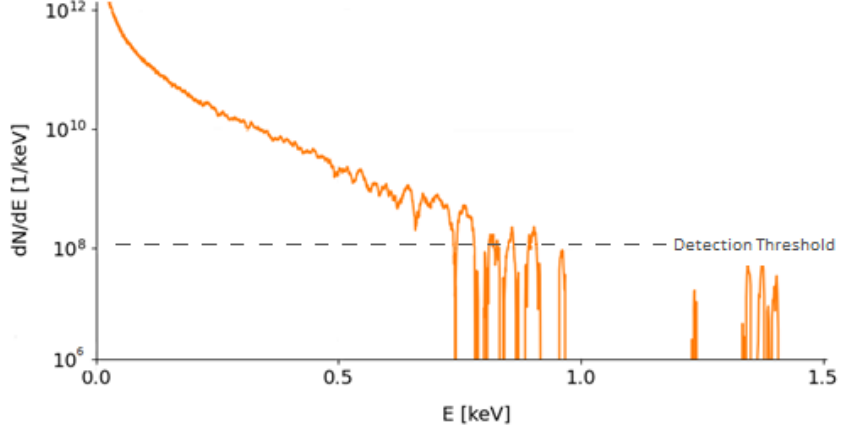
Figure 1. Typical energy distribution obtained from residual ion acceleration. Data gathered from an experimental campaign that was performed at HiLASE centre, intensity 2.2 × 10 16 W/cm 2 laser shots incident on a 2 mm Cu target. Detection threshold marks (in KeV) the value at which the signal noise becomes equal to the signal received, disallowing accurate detection below it.